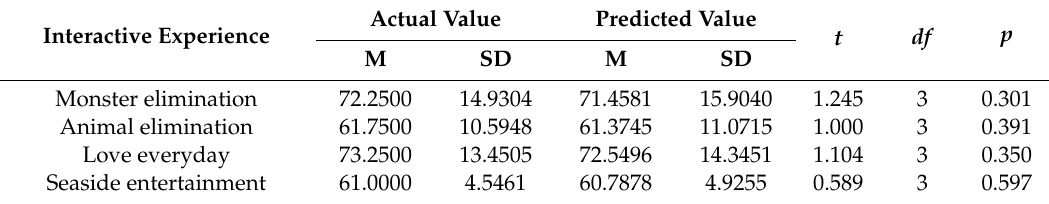
Table 5. The test results of the actual value and predicted value in the task-oriented stage. Actual Interactive Experience